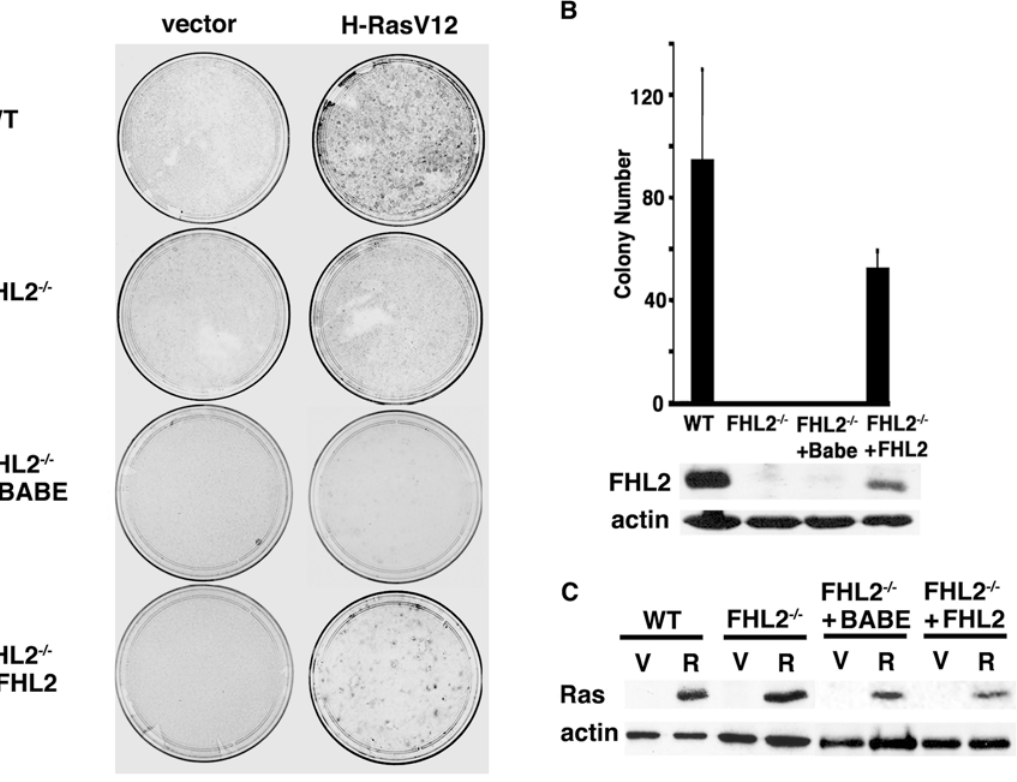
Figure 1. Absence of foci formation in immortalized FHL2 2 / 2 MEFs upon expression of H-RasV12. (A) Focus formation assay of MEFs transiently transfected with H-RasV12 or empty vector. Plates were stained with Giemsa at 3 weeks after transfection. Data are representative of at least 3 independent experiments using 3 spontaneously immortalized clones. To restore FHL2 expression, primary FHL2 2 / 2 MEFs were infected with a retrovirus expressing FHL2 (pBabeFHL2puro) and cultured according to the 3T3 protocol. Two FHL2 -restored FHL2 2 / 2 cell pools were obtained and used in the study. pBabe vector was used as a control (Babe). (B) Chart depicting at least three independent experiments. Mean colony numbers 6 standard deviation are shown. Bottom: Immunoblot analysis of FHL2 expression in FHL2 -restored cell line. (C) Analysis of H-RasV12 expression in MEFs transfected with either empty (V) or H-RasV12 (R) expression vector. Samples were processed for immunoblotting 48 h after transfection. Actin was used as loading control.